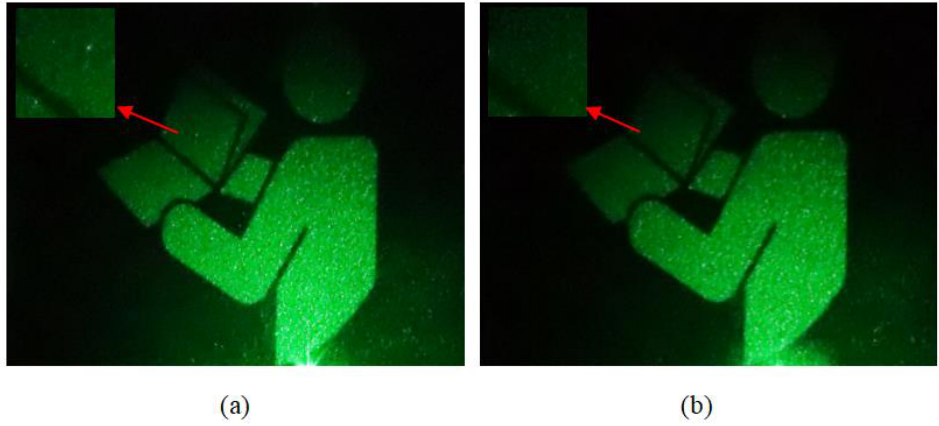
Figure 9. Results of the reconstructed image by using the proposed system based on the GS algorithm. ( a ) Result of loading the hologram without DOEs; ( b ) result of loading the hologram with DOEs.